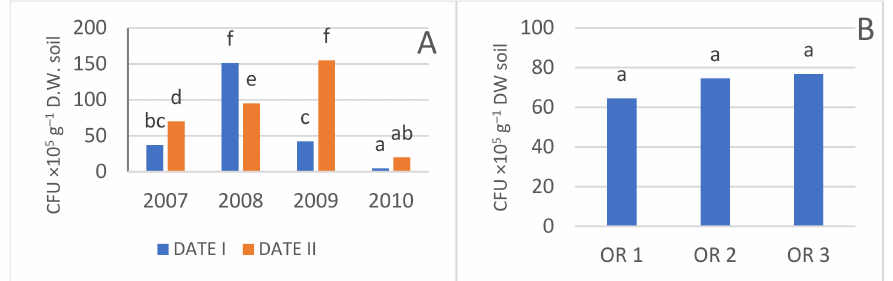
Figure 6. Number of actinomycetes in 2007–2010: ( A )—depending on the year and date of sampling; ( B )—depending on the orchard.